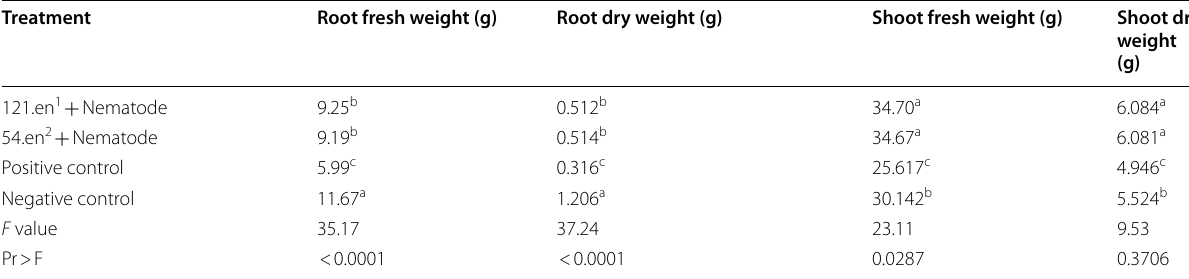
Table 3 Mean comparison of plant growth parameters in greenhouse experiment